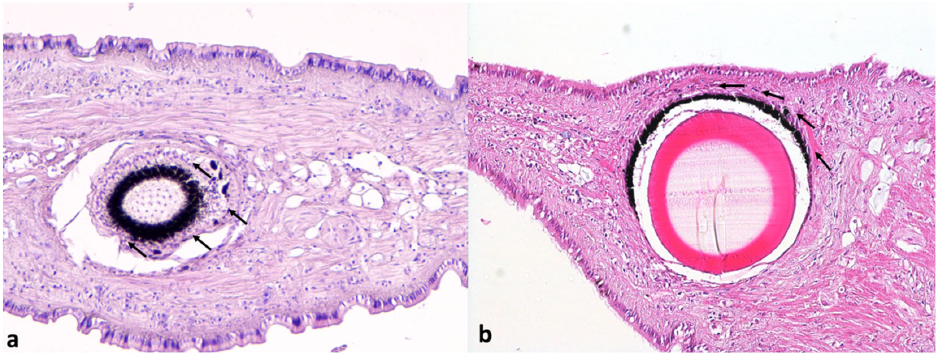
Figure 4. Eyes of T. mutabilis : ( a ) NNV ‐ negative and ( b ) NNV ‐ positive animals. The photoreceptors and basal retinal neurons (arrows) did not show signs of degeneration. Hematoxylin and eosin, magnification ×100.